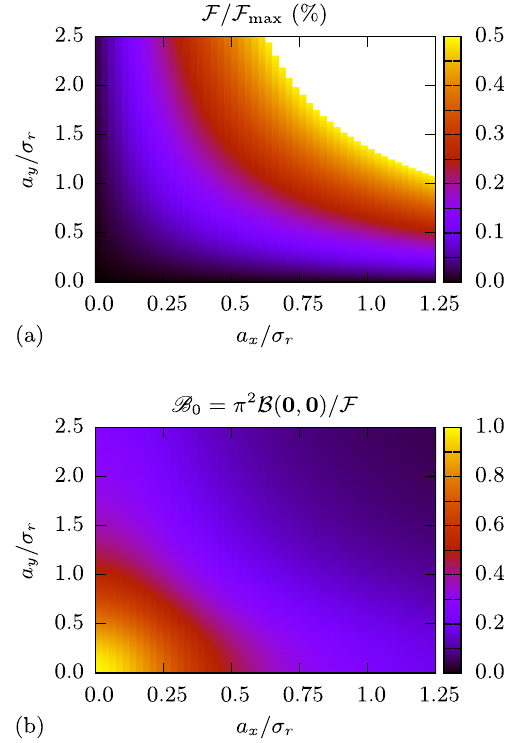
FIG. 2. Effectofasquareslitofsize a on the Gaussian-Schell model of undulator radiation using the parameters in Table I. (a) plots how the flux decreases with slit size, while(b)givesthecoherentfraction ℬ 0 .Toachieve50%coherence one sacrifices nearly 99.9% of the flux since 1 = ð ˆ ε